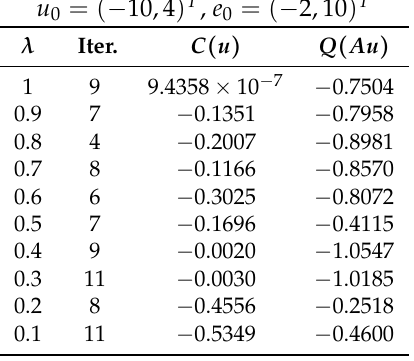
Table 2. Numerical results for solving Example 1 with different λ